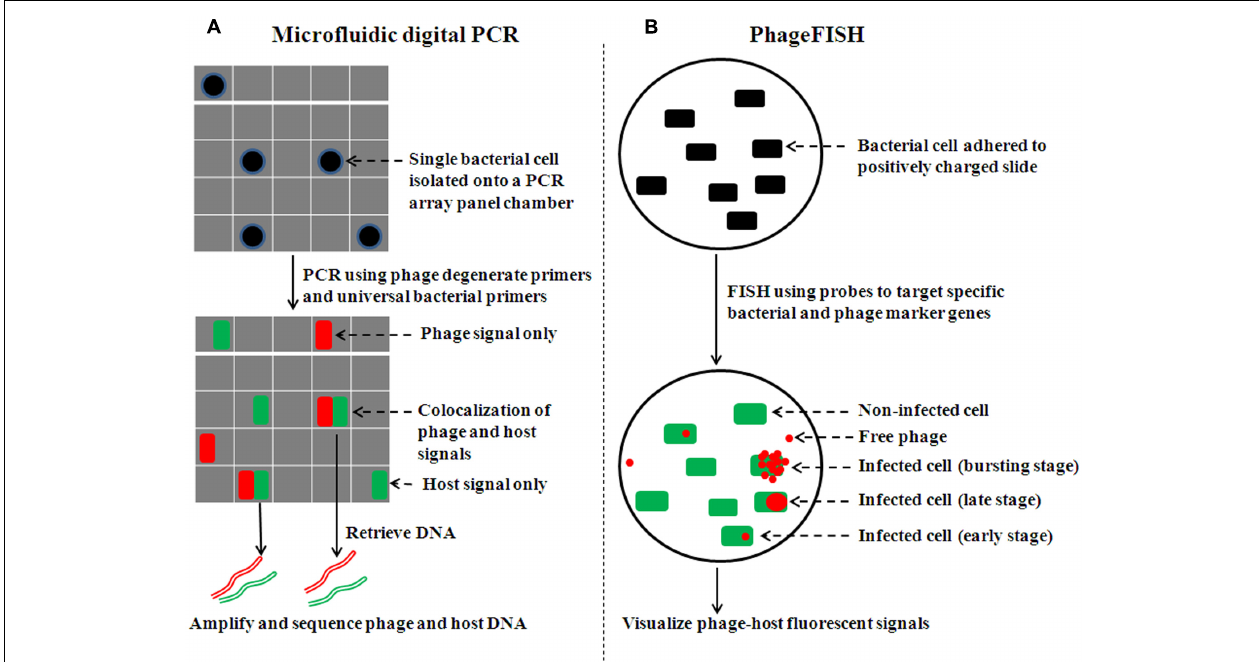
FIGURE 1 | Overview of procedures of single-cell experimental methods to examine phage–host interactions. (A) For microfluidic digital PCR, cells are sorted onto an array panel with the majority of chambers containing no or single cells (adapted fromTadmor etal., 2011). Concurrent amplification is carried out for both phage and bacterial marker genes. Co-localization of phage and bacterial signals is shown in FAM and HEX channels, respectively, with fluorescence in half of each PCR array chamber. (B) For phageFISH, the phage–host sample is either immobilized on 0.2 μ m filter membranes or